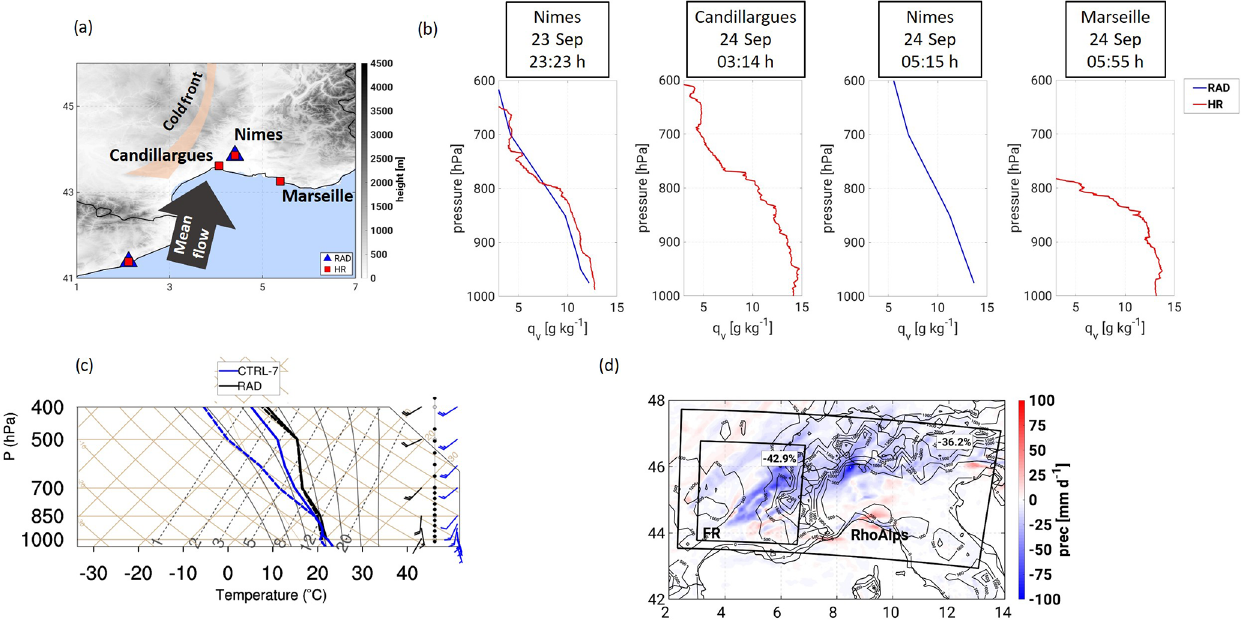
Figure 9. (a) Location of the stations with RAD and HR profiles between 23 September 23:23UTC and 24 September 05:55UTC, as well as cold front position and direction of the mean flow. (b) Radiosonde measurements (RAD and HR) in the area. (c) Skew-T log p diagram of the Nîmes radiosonde at 05:15UTC on 24 September and the simulation of the profile by CTRL-500, interpolated to the station location. (d) Precipitation differences between RAD-7 and the same simulation without the Nîmes sounding shown in panel (c) .